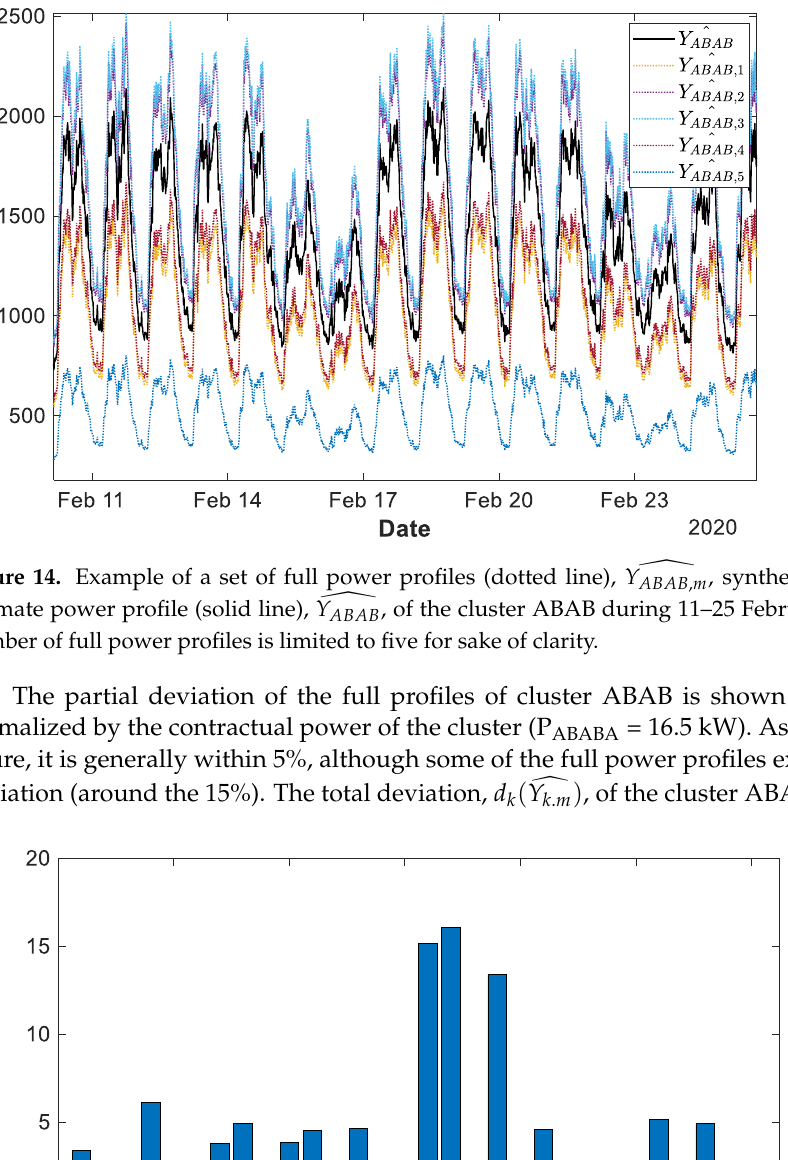
Figure 16. The partial error of the full energies profiles, 𝑌 𝐴𝐵𝐴𝐵,𝑚 ̂ , of cluster k = ABAB with the re- spect to the estimate power profile 𝑌 𝐴𝐵𝐴𝐵 ̂ . The error is normalized by the contractual power of the cluster ABAB (P ABAB = 16.5 kW). 4.3.2. Example of Cluster AAAA-BA The same metrics were calculated on the power profiles obtained from the sub-clus- ter AAAA-BA. As shown in Figure 17, the partial deviation (P AAAA-BA = 4 kW) is generally within 5%, although some of the full power profiles exhibit a larger deviation (in any case below 10%). The total deviation, 𝑑 𝑘 (𝑌 𝑘.𝑚 )̂ , of the sub-cluster AAAA-BA, is 2.9%. Similarly, the error of the sub-cluster, calculated with W ABAB = 30, is shown in Figure 18, which is always below 10%. The error is more equally distributed with the respect to the error of the cluster ABAB. The total error, 𝑒 𝑘 (𝑌 𝑘,𝑚 )̂ , of the cluster AAAA-BA is 4.2%. It should be noted that the condition expressed by (15) is satisfied also in this case, since the total error of full profiles is below the total error of the profile estimator of the cluster AAAA-BA (i.e., 4.9%).